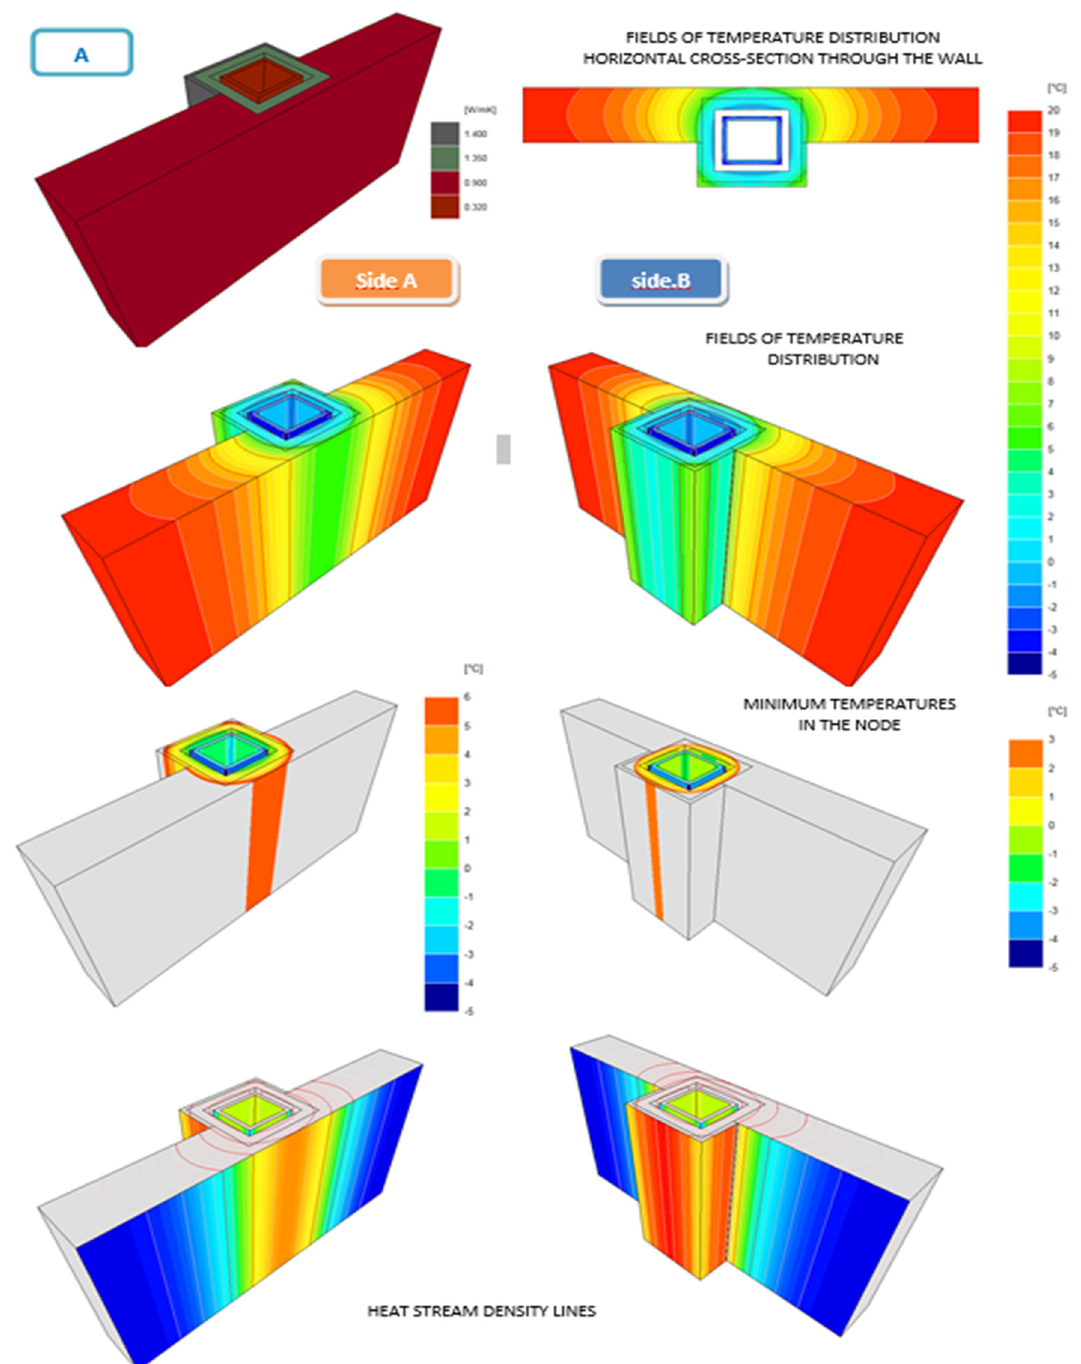
Figure A1. Scheme A: isotherm field distribution, minimum surface temperature, and heat flux distribution.